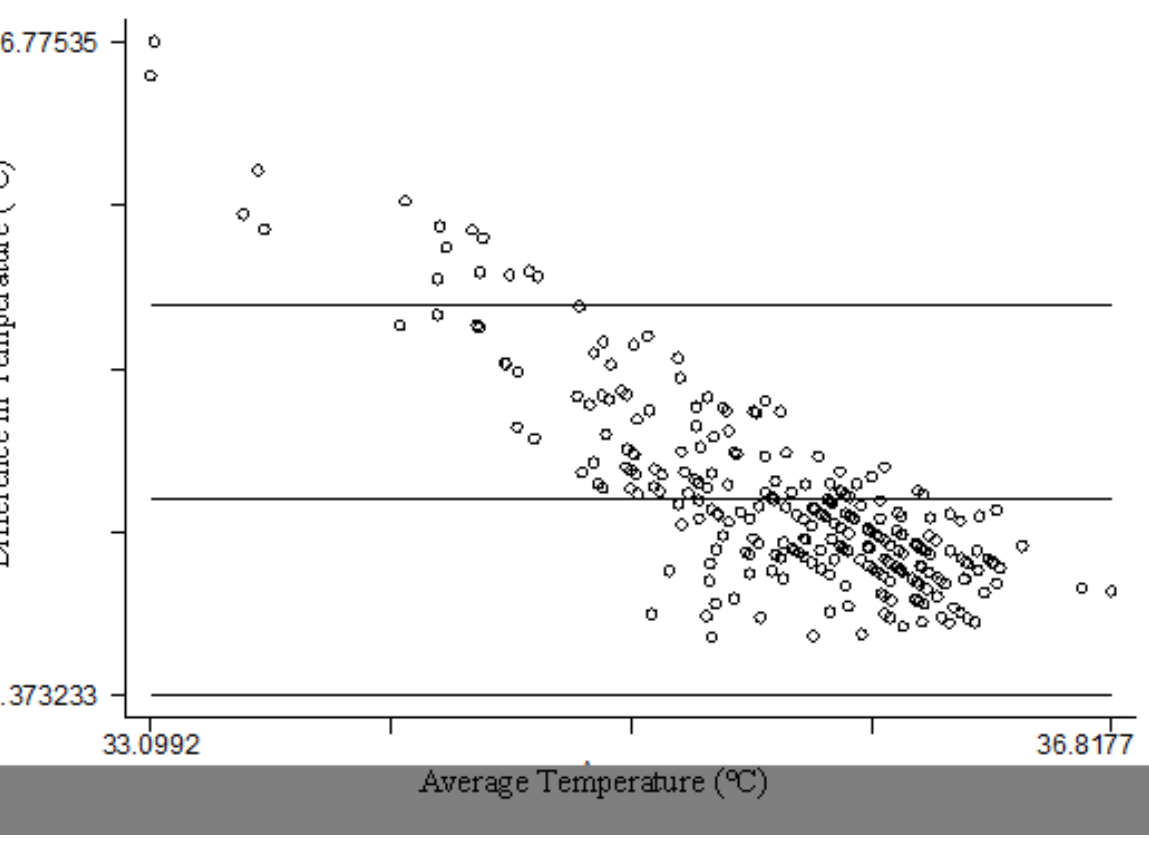
Figure 3. Bland-Altman comparison of thermometer and average temperature, for the 60-minute interval before waking recorded by BMSW (each dot represents one participant’s temperature readings using the thermometer and BMSW).